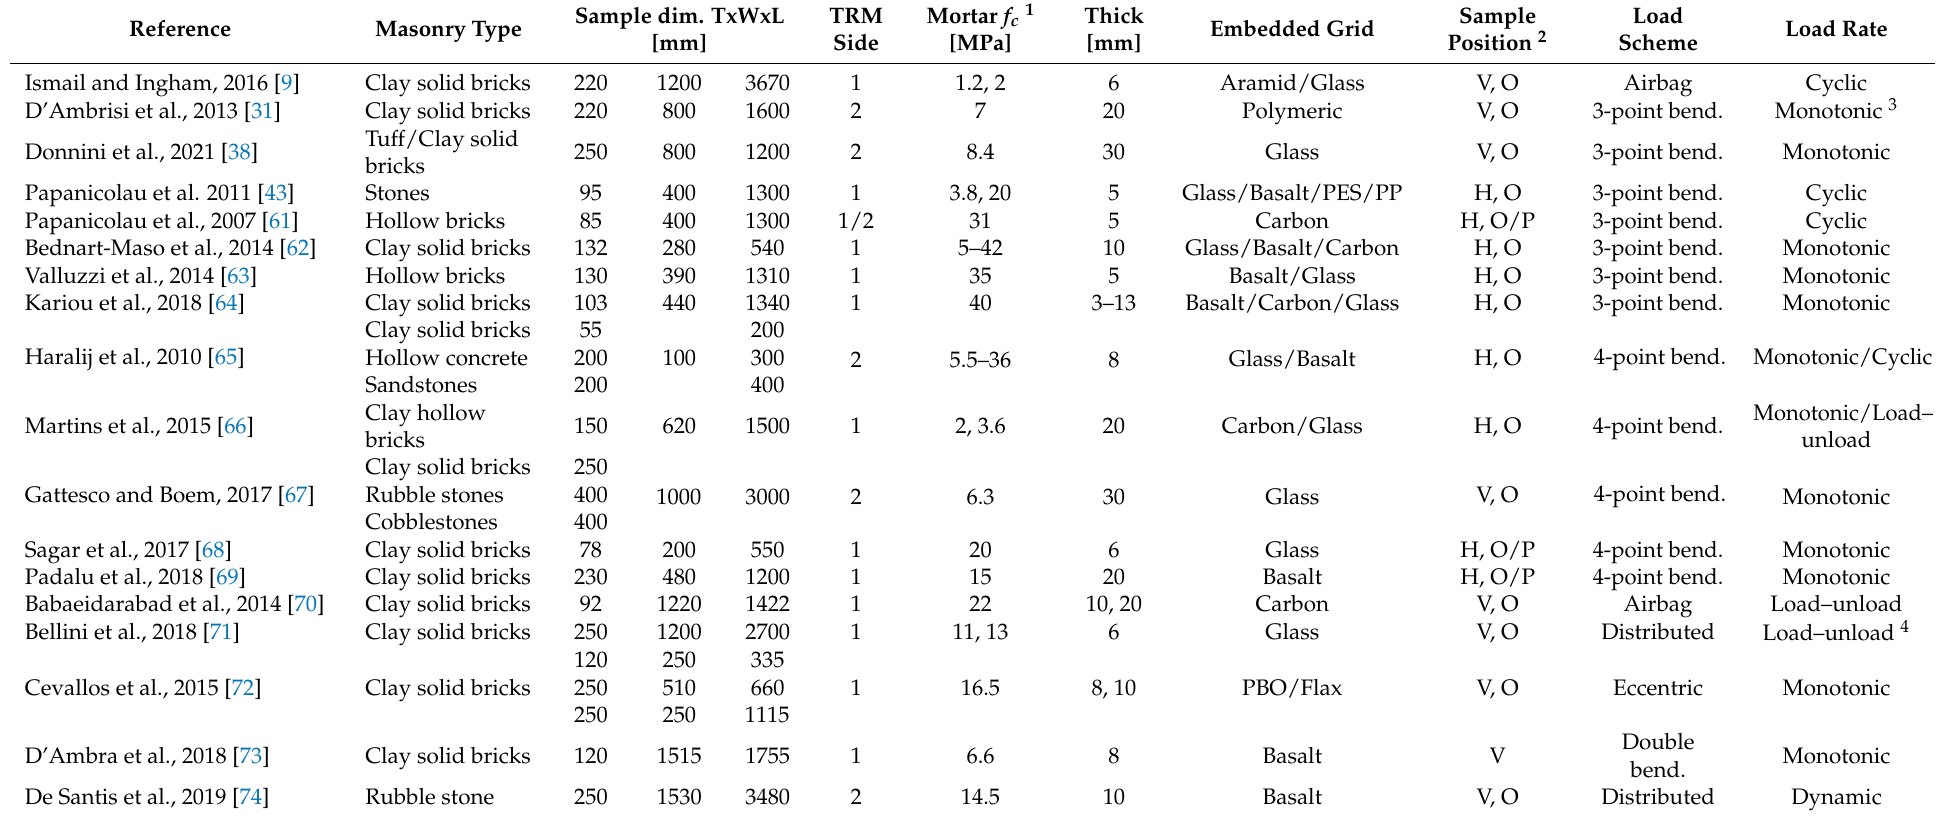
Table 3. Summary of out-of-plane experimental bending